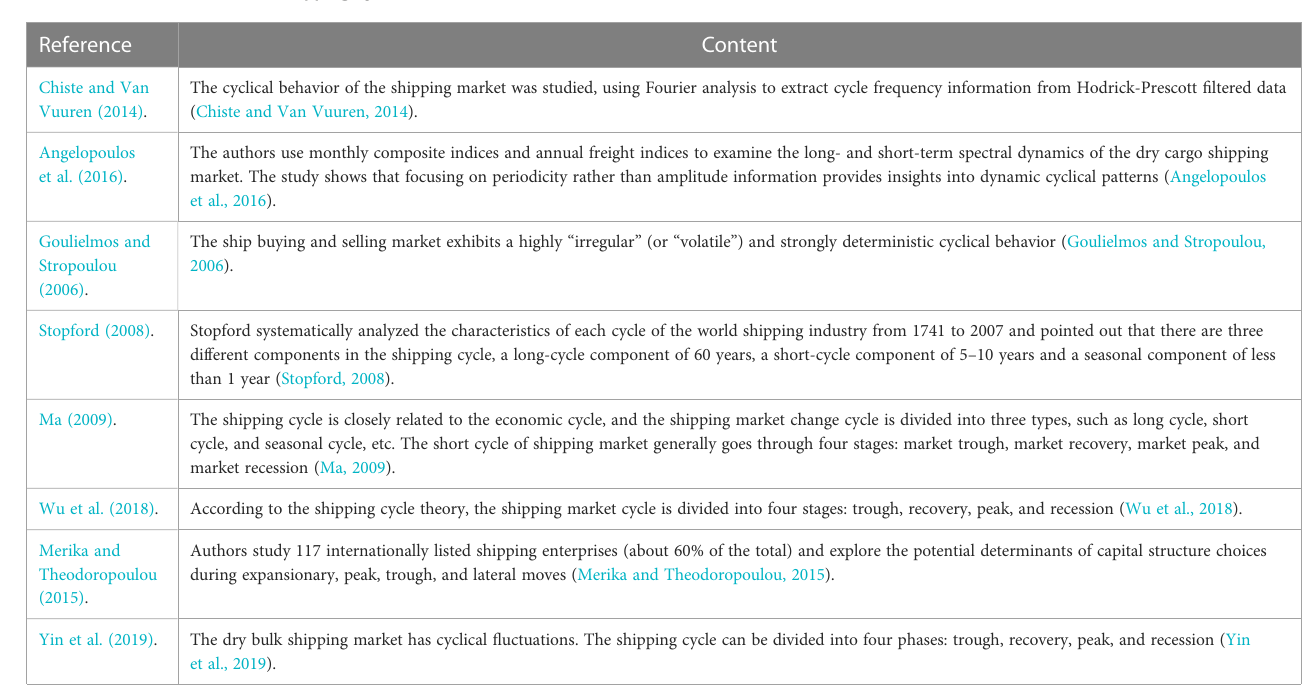
TABLE 1 The rationale for the shipping